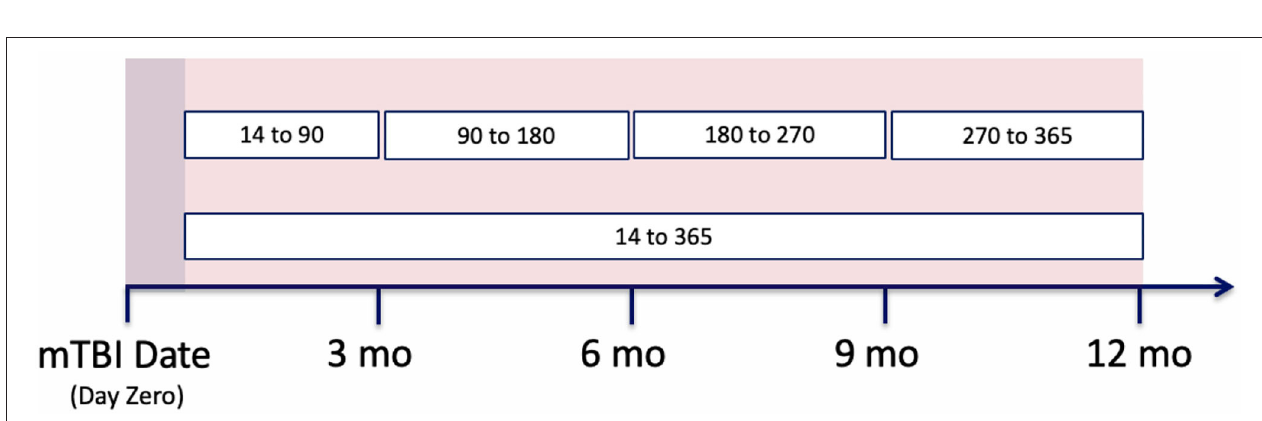
FIGURE 5 | Prediction period split into different patients’ clinical trajectories, split into observation and prediction periods. Then the observation period is further split into smaller window configurations.